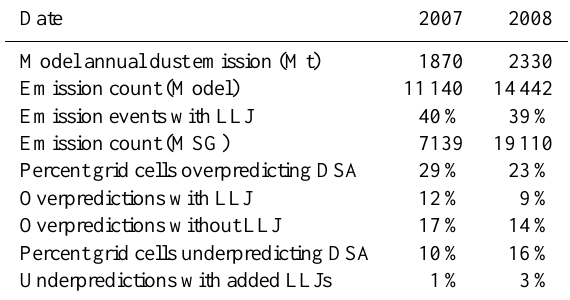
Table 1. Sahara dust results from the regional model COSMO- MUSCAT for the years 2007 and 2008. DSA: Dust source activa- tion. Over- and underpredictions refer to the percentage of grid cells between 15 ◦ W, 10 ◦ N and 32 ◦ E, 40 ◦ N that are activated compared to MSG IR dust index.